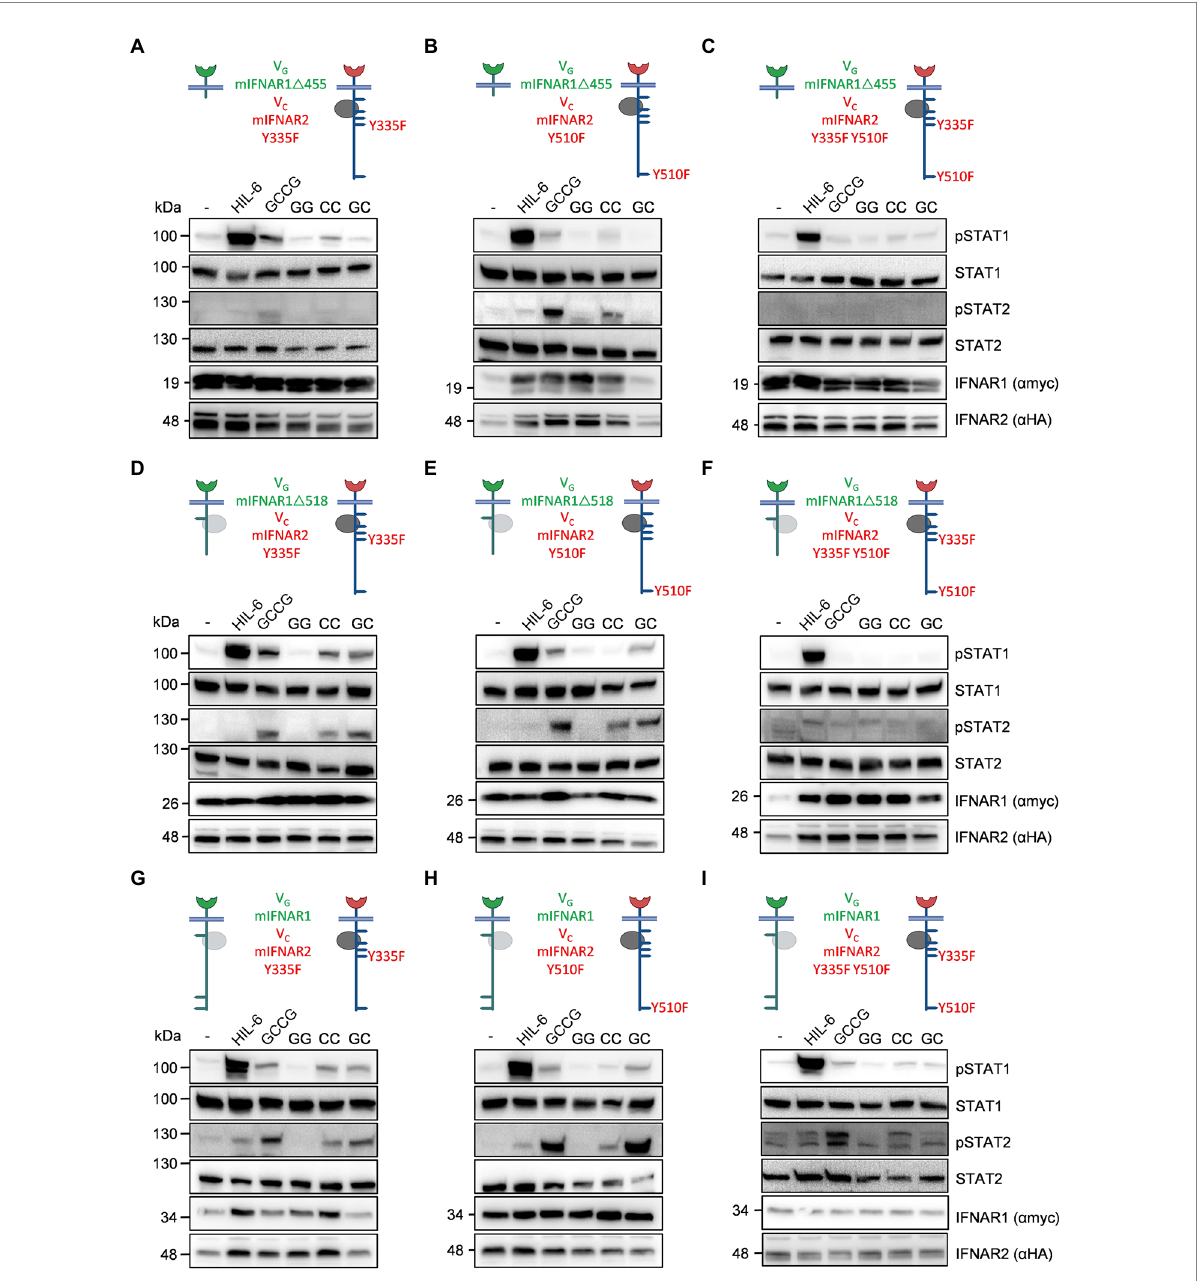
FIGURE 7 Point mutation variants for synthetic murine IFNARs support the importance of Y510 in IFNAR2. The following murine receptor combinations were transiently transfected into HEK293 cells: (A) V G IFNAR1 Δ 455 and V C IFNAR2_Y335F, (B) V G IFNAR1 Δ 455 and V C IFNAR2_Y510F, (C) V G IFNAR1 Δ 455 and V C IFNAR2_Y335F_Y510F, (D) V G IFNAR1 Δ 518 and V C IFNAR2_Y335F, (E) V G IFNAR1 Δ 518 and V C IFNAR2_Y510F, (F) V G IFNAR1 Δ 518 and V C IFNAR2_ Y335F_Y510F, (G) V G IFNAR1 and V C IFNAR2_Y335F, (H) V G IFNAR1 and V C IFNAR2_Y510F, and (I) V G IFNAR1 and V C IFNAR2_Y335F_Y510F. Conserved tyrosine residues between human and murine receptors are indicated. ( A–H ) STAT1 and STAT2 activation was determined in transiently transfected HEK293 cells treated with 10 ng/ml Hyper-IL-6, 100 ng/ml of the synthetic cytokine ligands (GCCG, GG, CC, GC) for 30 min. Equal amounts of proteins (50 μ g/lane) were analyzed via specific antibodies detecting phospho-STAT1, phospho-STAT2, STAT1, STAT2, IFNAR1 (myc-tagged), and IFNAR2 (HA-tagged). Western blot data shows one representative experiment out of